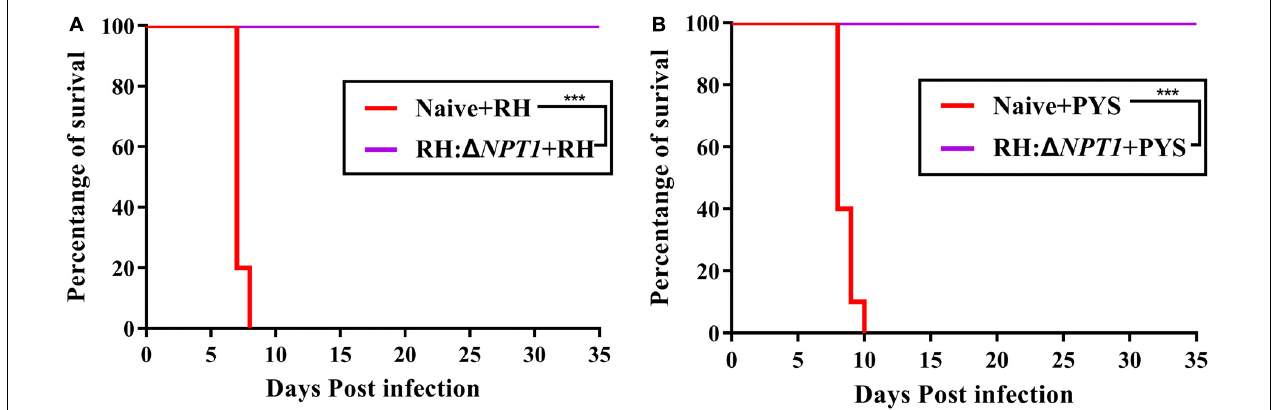
FIGURE 5 | RH: (cid:49) NPT1 vaccination protected against acute T. gondii infection. At 42 days post-immunization, mice were challenged with 1 × 10 3 tachyzoites of the RH (A) and PYS (B) strains by intraperitoneal injection. The survival rates of the immunized and non-immunized mice were monitored for 35 days. Survival curves showed the immunized mice had a high survival rate compared with the positive control (non-immunized mice) ( n = 10; ∗∗∗ P < 0.001; n.s. , not significant;